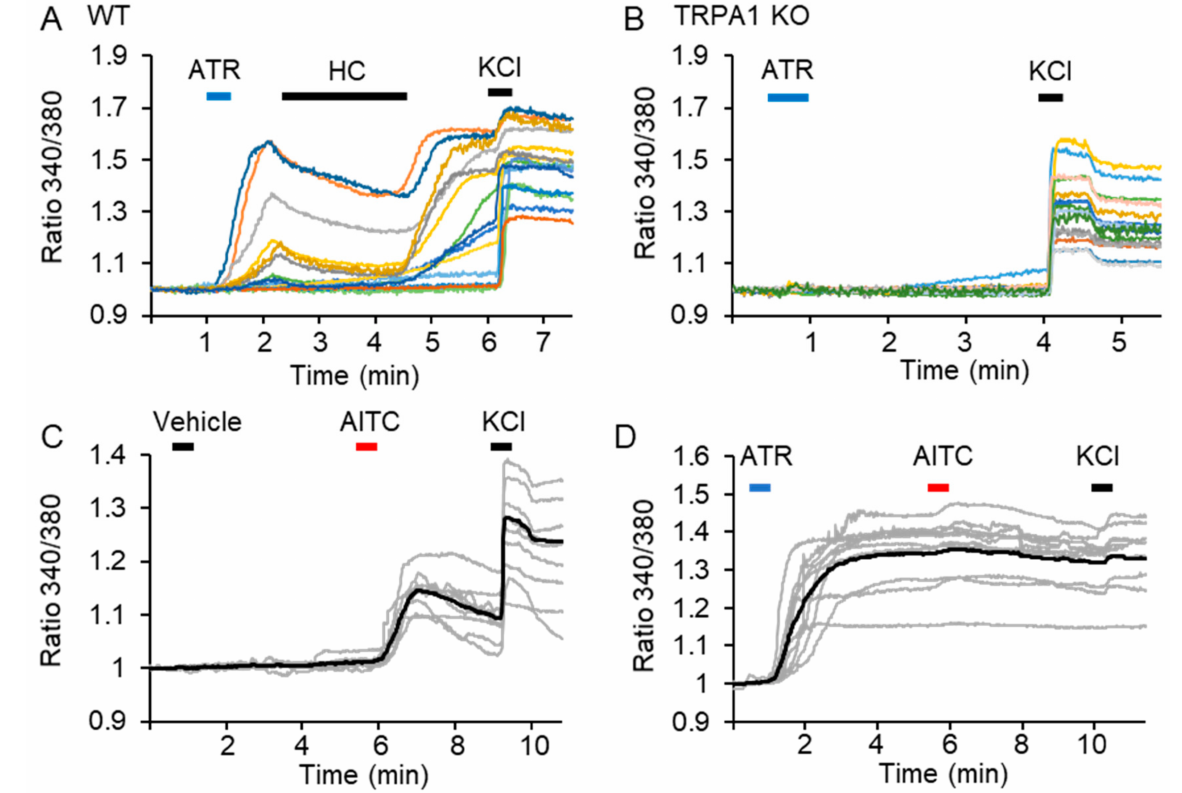
Figure 4. Atractylodin (5 µ M) selectively activated transient receptor potential ankyrin-1 (TRPA1) channel in dorsal root ganglion (DRG) neurons. ( A , B ) Calcium imaging analysis with primary cultured DRG neurons from wild-type ( A ) and TRPA1 KO mice ( B ). Ratiometric measurement of Fura-2AM was performed to analyze cytosolic Ca 2+ level. Calcium response from different cells is shown in various colors. The effect of HC-030031 on the ATR induced calcium response on cultured DRG neurons of WT mice (63 cells, n = 3) ( A ) and the effect of ATR on cultured DRG neurons from TRPA1 KO mice (95 cells, n = 3) ( B ). ( C , D ) Calcium imaging analysis with rat primary cultured DRG neurons. Calcium response from different cells is shown in gray lines, and the average response is shown in the black line (12 cells: C; 13 cells: D). ATR: atractylodin; HC: HC-030031; WT: wild-type; KO: knockout.